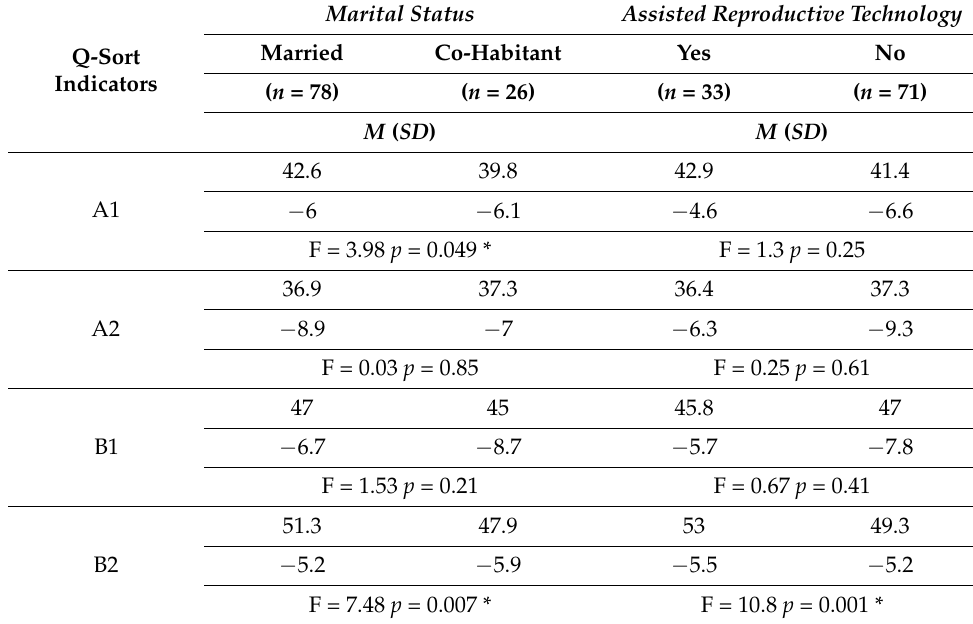
Table 7. Maternal competence (Q-sort scores) in NICU (T1) in relation to levels of marital status of the mothers and medically assisted procreation (MANOVA) ( n =